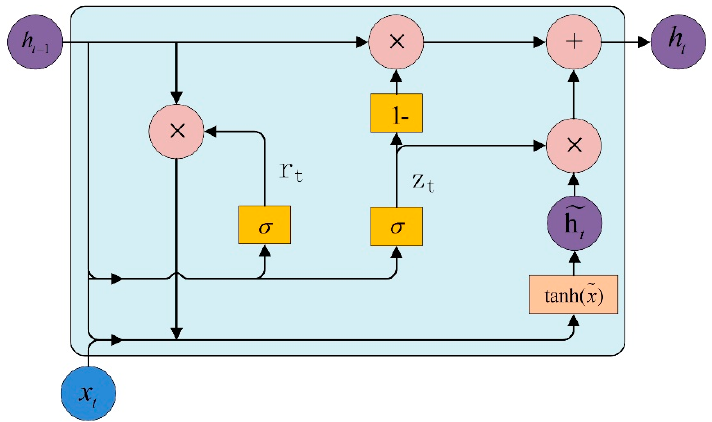
Figure 3. Schematic diagram of the GRU neural network structure, which describes the detailed information of the transfer process.